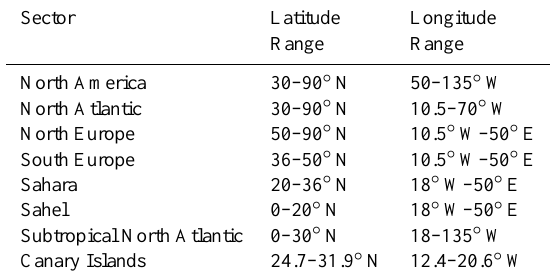
Table 2. Geographical sectors used in the backward trajectory clas- sification (function of the continental source regions and oceanic sectors, latitude and longitude